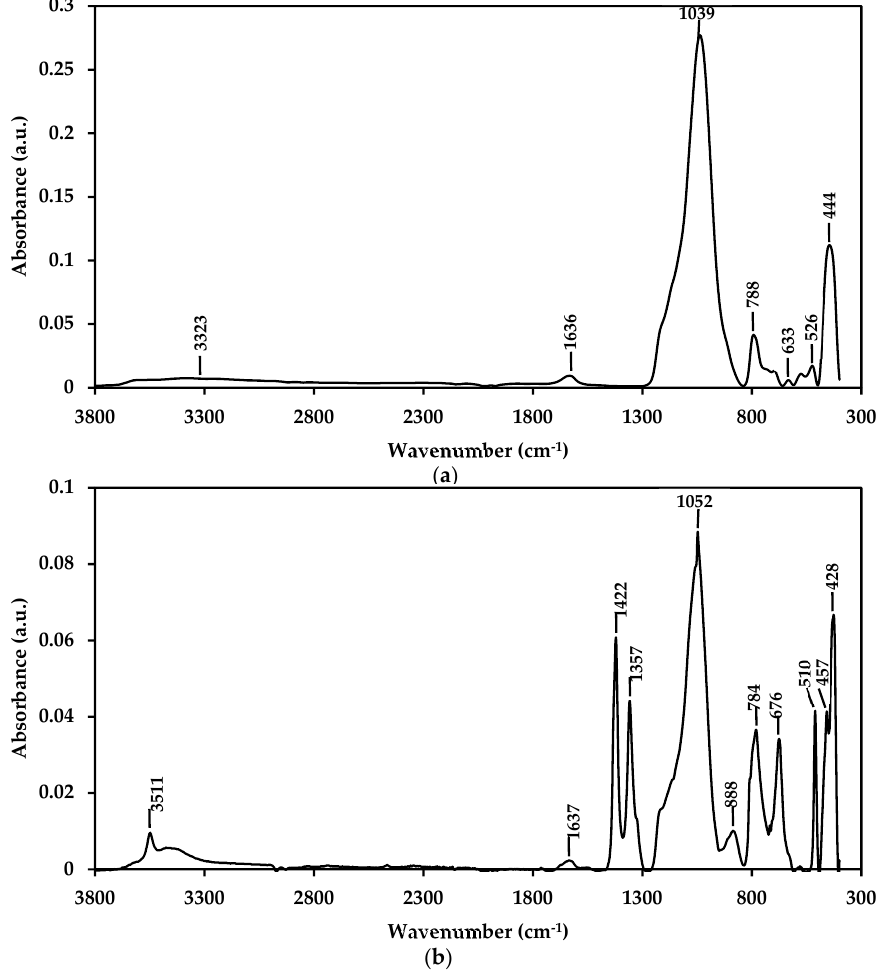
Figure 6. FTIR spectra of samples of natural zeolite. ( a ) nZH; ( b ) nZH-Cu.